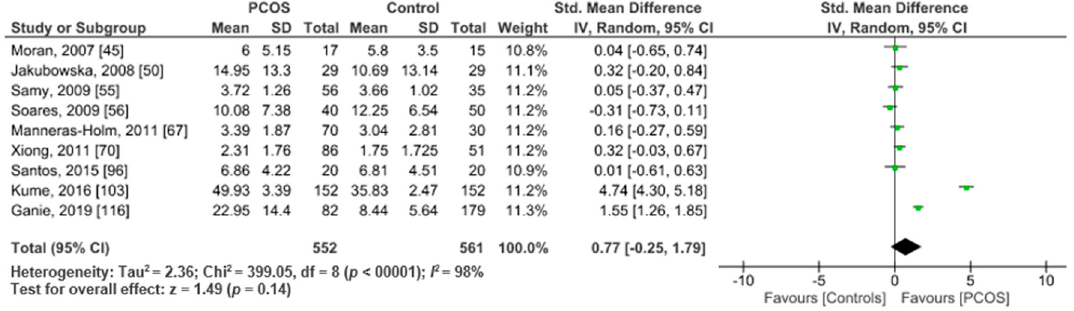
Figure 6. TNF- α metanalysis of 9 studies.